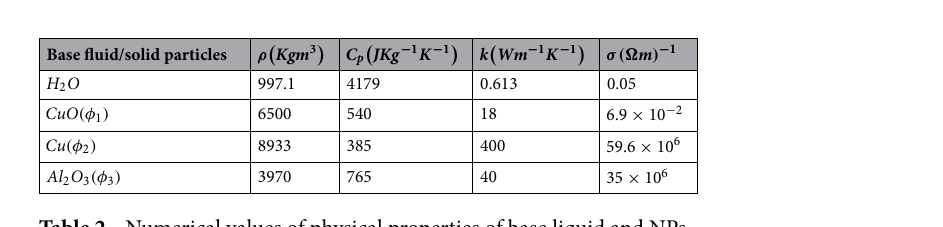
Table 2. Numerical values of physical properties of base liquid and